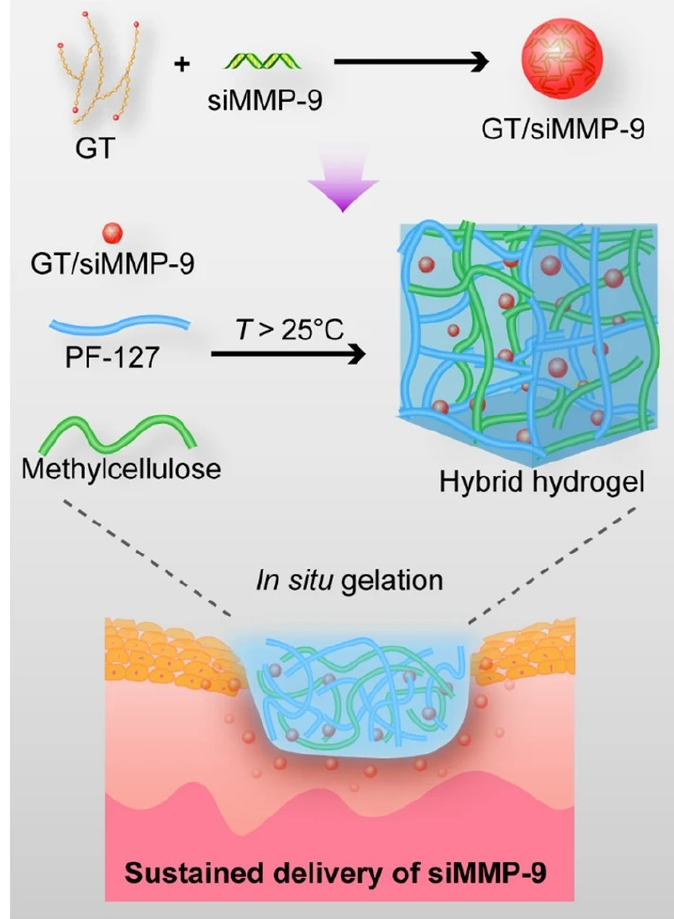
Figure 4. The schematic illustration of the preparation of the hybrid hydrogel dressing fabricated by Biyun Lan et al. Reproduced with permission [91].